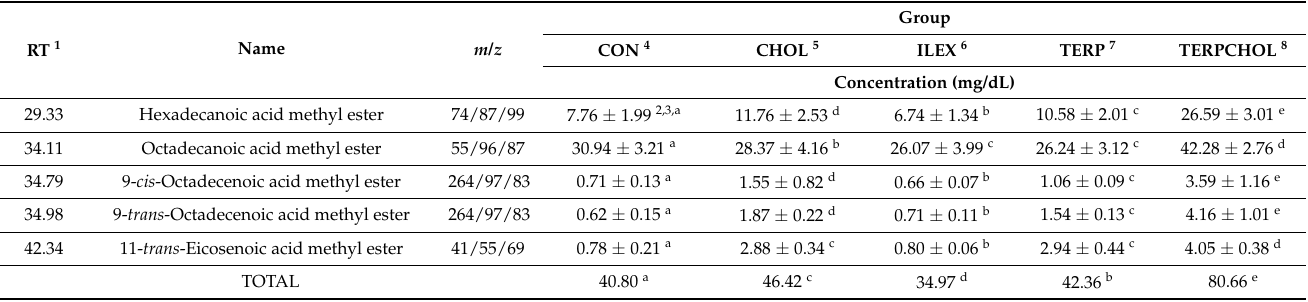
Table 12. Fatty acid profile of urine in normal or hypercholesterolemic Wistar rats after treatment with I. aquifolium and terpenoid